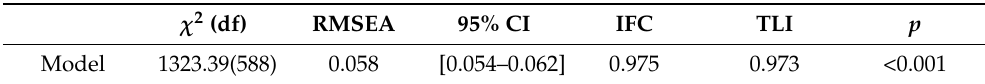
Table 3. Model fit